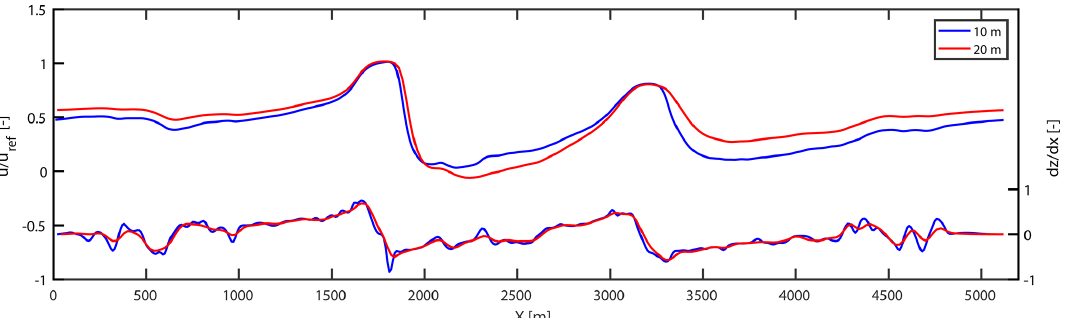
Figure 7. Comparison of streamwise velocity at the hub height without turbine and local slopes along the main transect for the two grid resolutions.